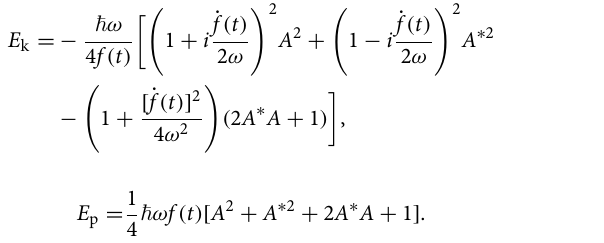
0 , and ϕ 1 , (cid:31) 1 , ǫ 1 , t 0 1 , ω 0 . In = = = = = = 4 =